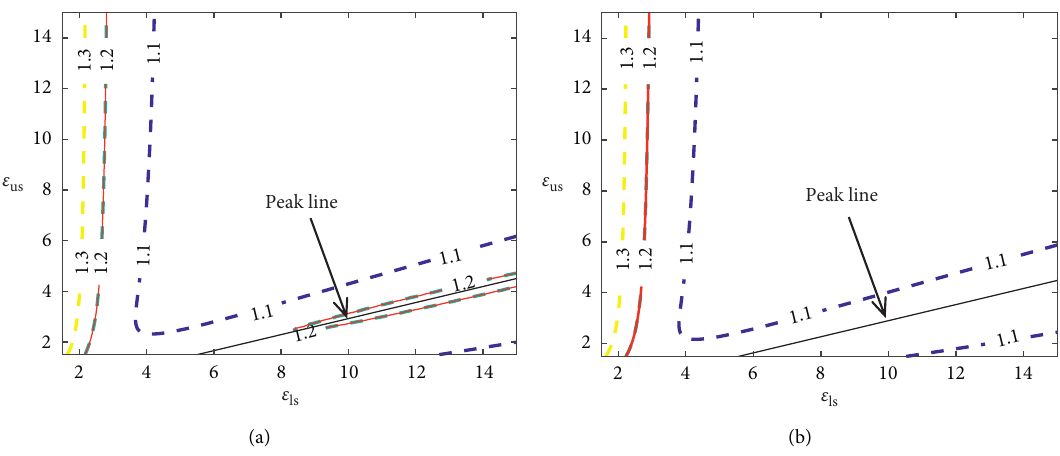
Figure 6: Contour plots of R a